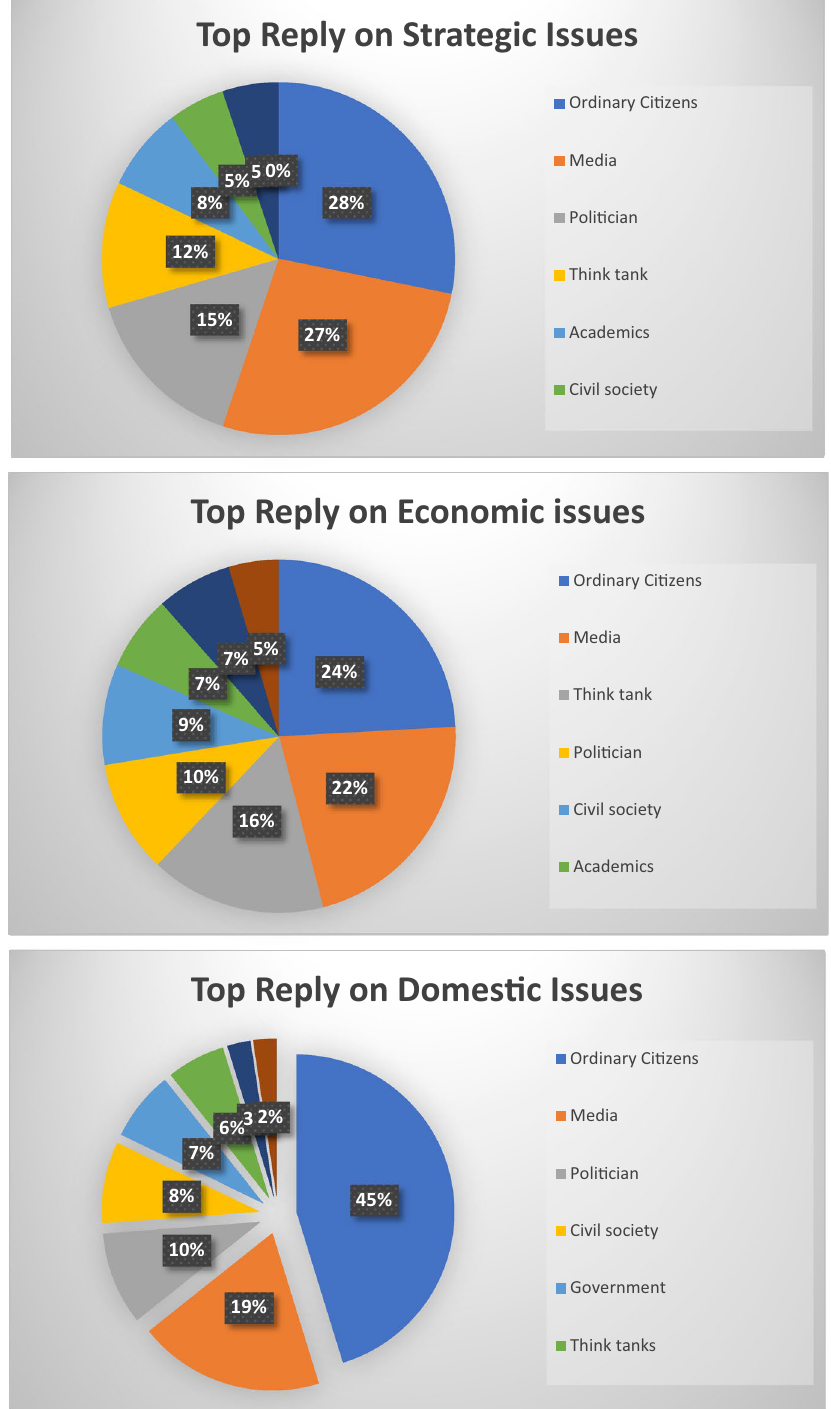
Fig. 14 Top 200 replies on strategic, economic, and domestic